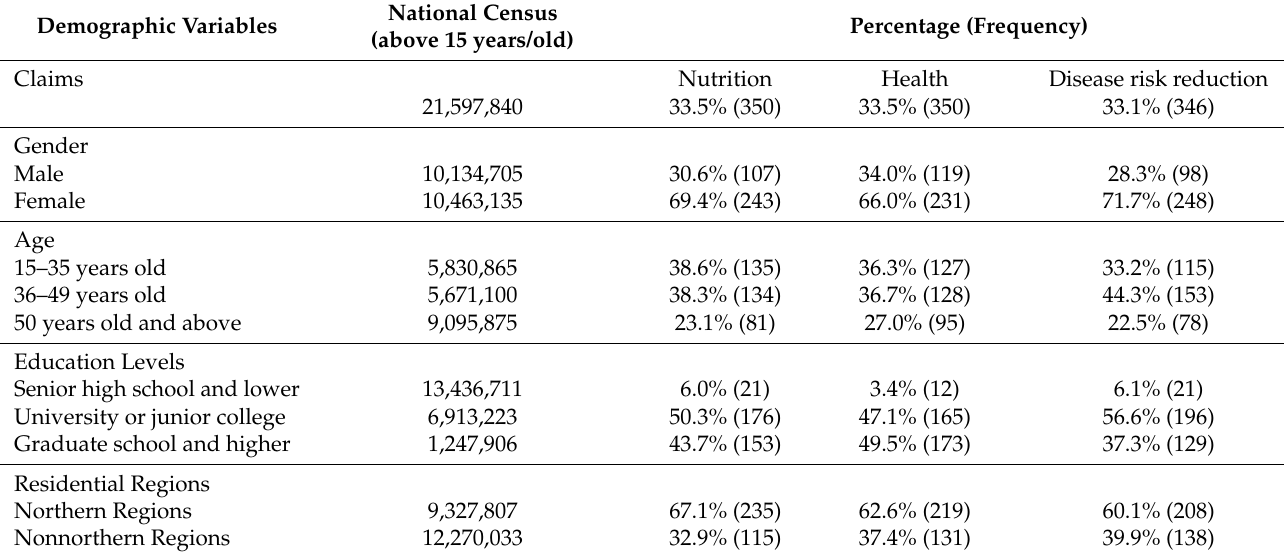
Table 1. Respondent demographics ( n =